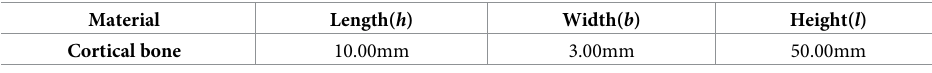
Table 1. The dimensions of the cortical bone